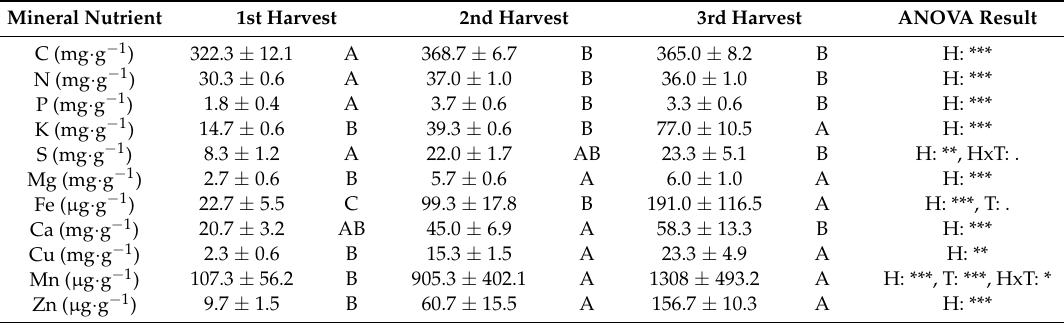
Table 6. Average leaf mineral concentrations ( ± SD) shown for the three harvests and the corresponding ANOVA results. Different letters indicate significant differences (Tukey’s HSD, n = 3, p < 0.05) for harvests. The effect of factors (harvest (H) and treatment (T)) and their interaction (H*T) were reported by “***” for p < 0.001, “**” for p < 0.01, “*” for p < 0.05 and “.” for p < 0.1. Mineral Nutrient